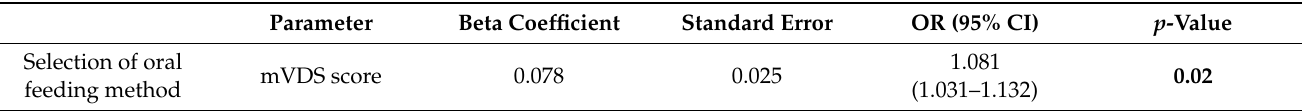
Figure 1. ( A ) ROC curve of the mVDS score for the selection of oral feeding in patients with ALS and dysphagia. The optimal cut-off value (dots on the curves) of the mVDS score, which was obtained from the maximal Youden index, was >69.5 (AUC, 0.886; 95% CI, 0.730–0.969; p < 0.0001; sensitivity, 71.43%; specificity, 100.0%). ( B ) ROC curve of the mVDS score for the development of aspiration pneumonia in patients with ALS and dysphagia. The optimal cut-off value obtained from the maximal Youden index was a score of >87 based on the mVDS (AUC, 0.886; 95% CI, 0.730–0.969; p < 0.0001; sensitivity, 80.0%; specificity, 93.1%) for the selection of oral feeding. ROC: receiver operating characteristic, AUC: area under the receiver operating characteristic curve, CI: confidence interval, mVDS: modified version of the videofluoroscopic dysphagia scale. Table 3. Univariate logistic regression analysis (with the enter method) of the association between the modified version of the Videofluoroscopic Dysphagia Scale scores and the selection of the oral feeding method.